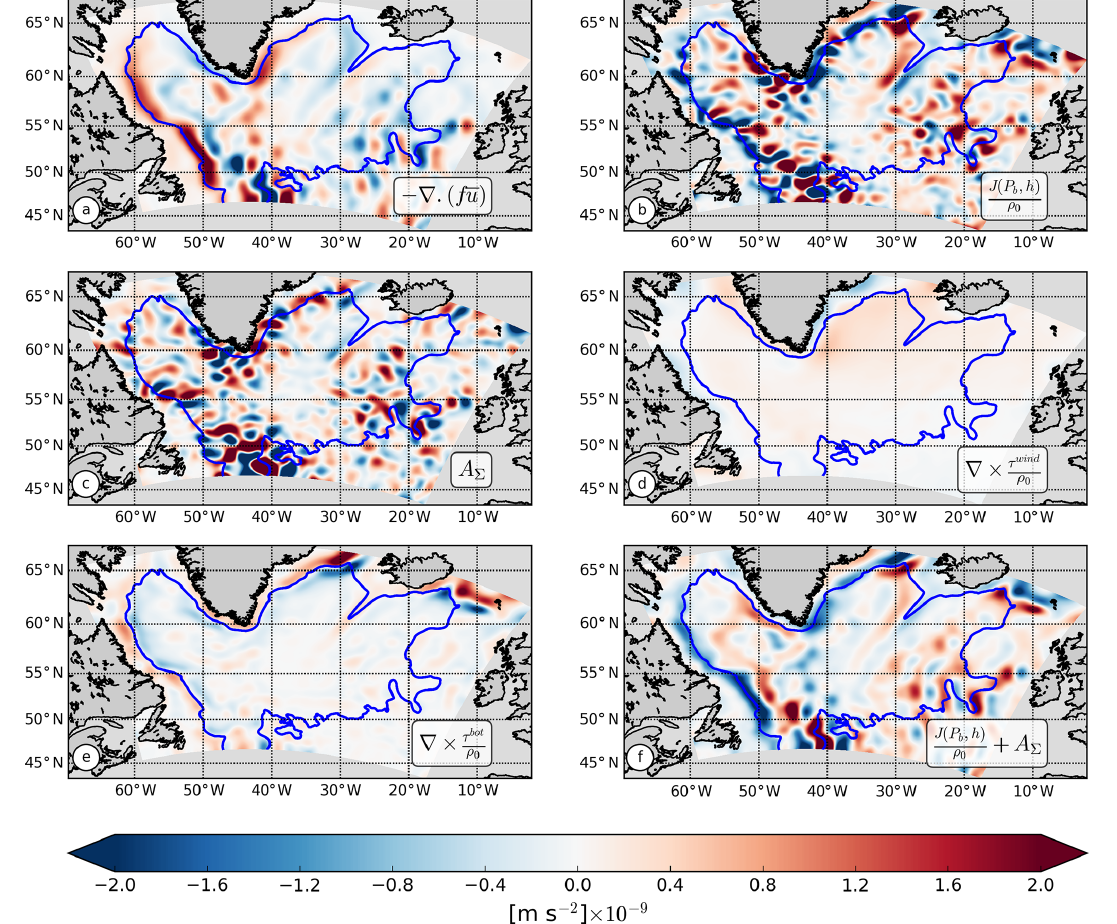
Figure 7. Time mean of the planetary vorticity (a) , bottom pressure torque (b) , nonlinear terms (c) , wind stress curl (d) , and bottom drag curl (e) . As bottom pressure torque and nonlinear terms cancel each other, their sum is plotted in (f) . The fields have been smoothed using a kernel of 1 ◦ radius. The blue contour represents the limit of our shelf area and is the − 3Sv barotropic